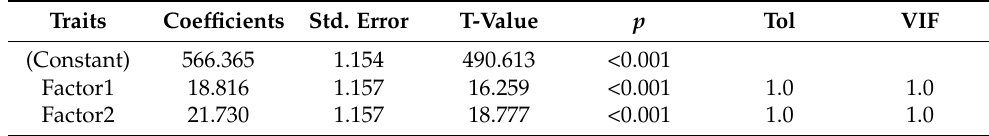
Table 6. Regression analysis results according to the factor analysis results. Traits Coefficients Std.